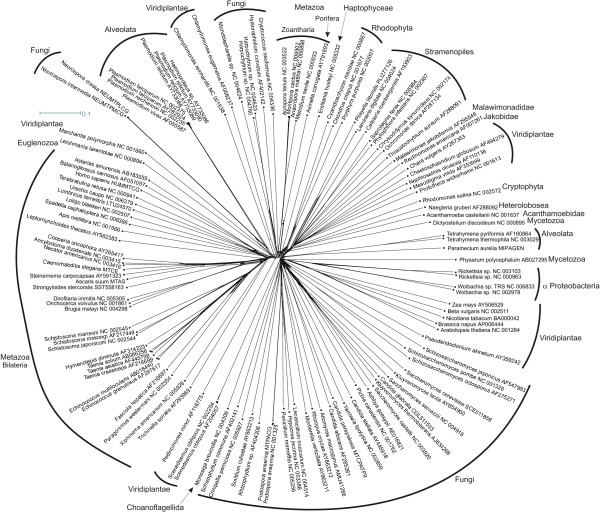
Neighbor-net reconstruction based on GBDP distances between whole mitochondrion genomes. The GBDP variant used was derived by scaling and averaging distance matrices based on HSP search with BLASTN and TBLASTX, respectively. Further settings were use of equations (2) and (6) and averaging of asymmetric distance values. With BIONJ as tree reconstruction method, this distance matrix achieved the highest c-score (0.5574), i.e., highest topological accuracy according to the current NCBI taxonomy, of all GBDP trees inferred from mitochondrial genomes. The matrix' δ value was 0.2946, indicative of a relatively high distance quality compared to the other results obtained with mitochondrial genomes. Bacterial outgroup taxa and major eukaryotic groups are indicated. Note the apparently low resolution of the network as compared to the best results obtained with plastid genomes (Figs. 4 and 5). Nevertheless, quite a few subgroups of the major eukaryotic groups are well recovered.